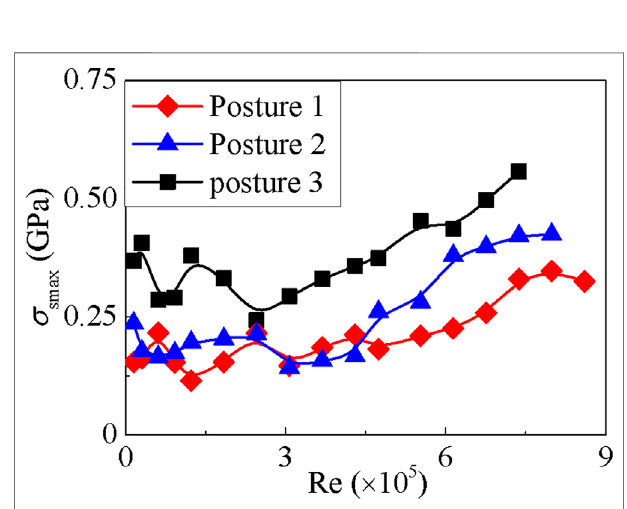
FIGURE 6 | The relationship between the maximum stress of the shell and the Reynold number Re.